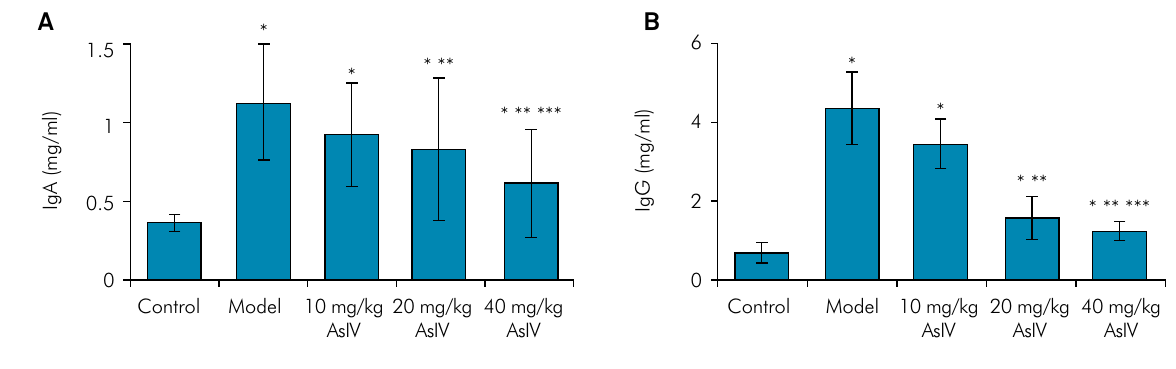
Figure 3. Serum IgA, IgG and IgM levels in different groups after treatment. A: IgA; B: IgG; and C: IgM. * p < 0.05 compared with the control group; ** p < 0.05 compared with the model group; and *** p < 0.05 compared with the 10 mg/kg AsIV group. AsIV, astragaloside IV; IgA, immunoglobulin A; IgG, immunoglobulin G; and IgM, immunoglobulin